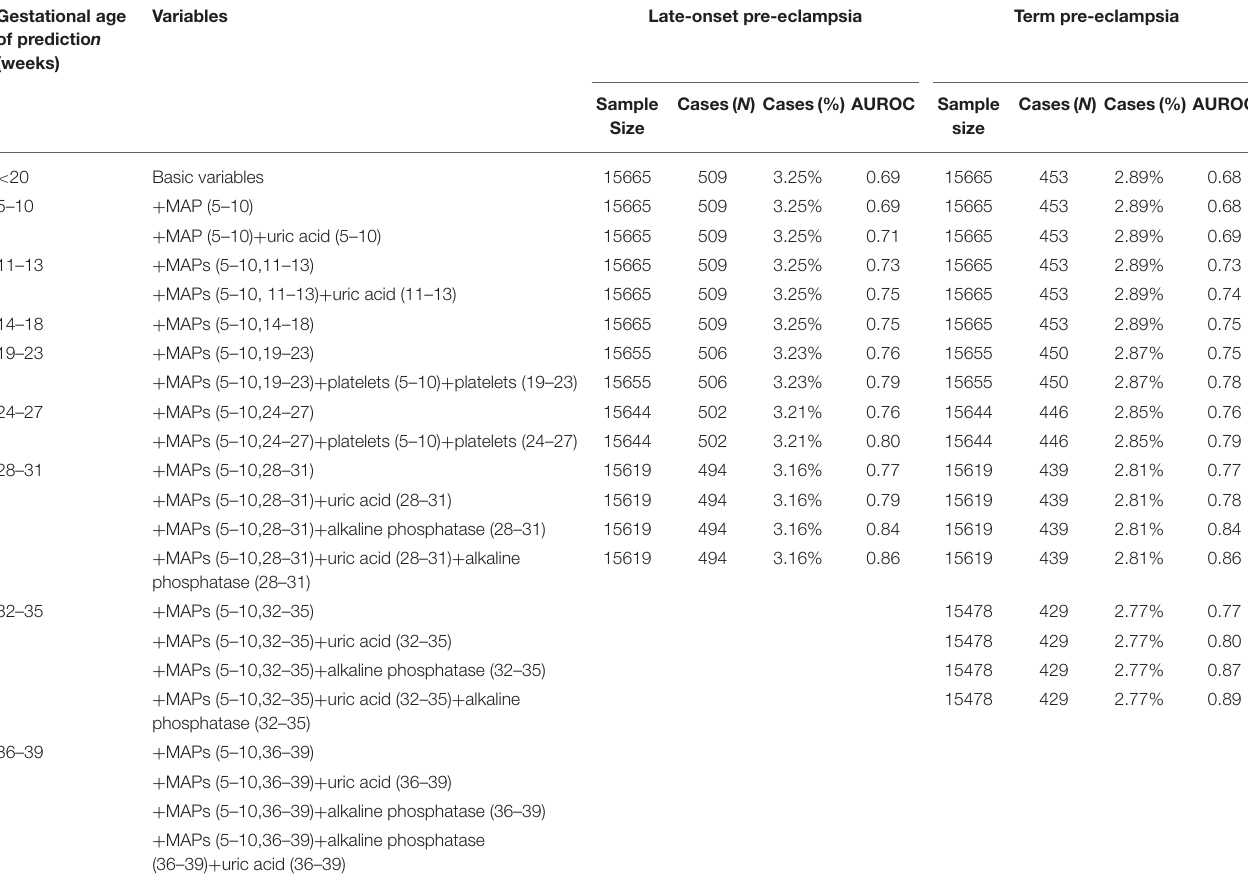
TABLE 2B | Performance of prediction model based on characteristics, medical history, mean arterial pressure, and biomarkers for late-onset and term pre-eclampsia. Gestational age Variables Late-onset of predictio n (weeks)